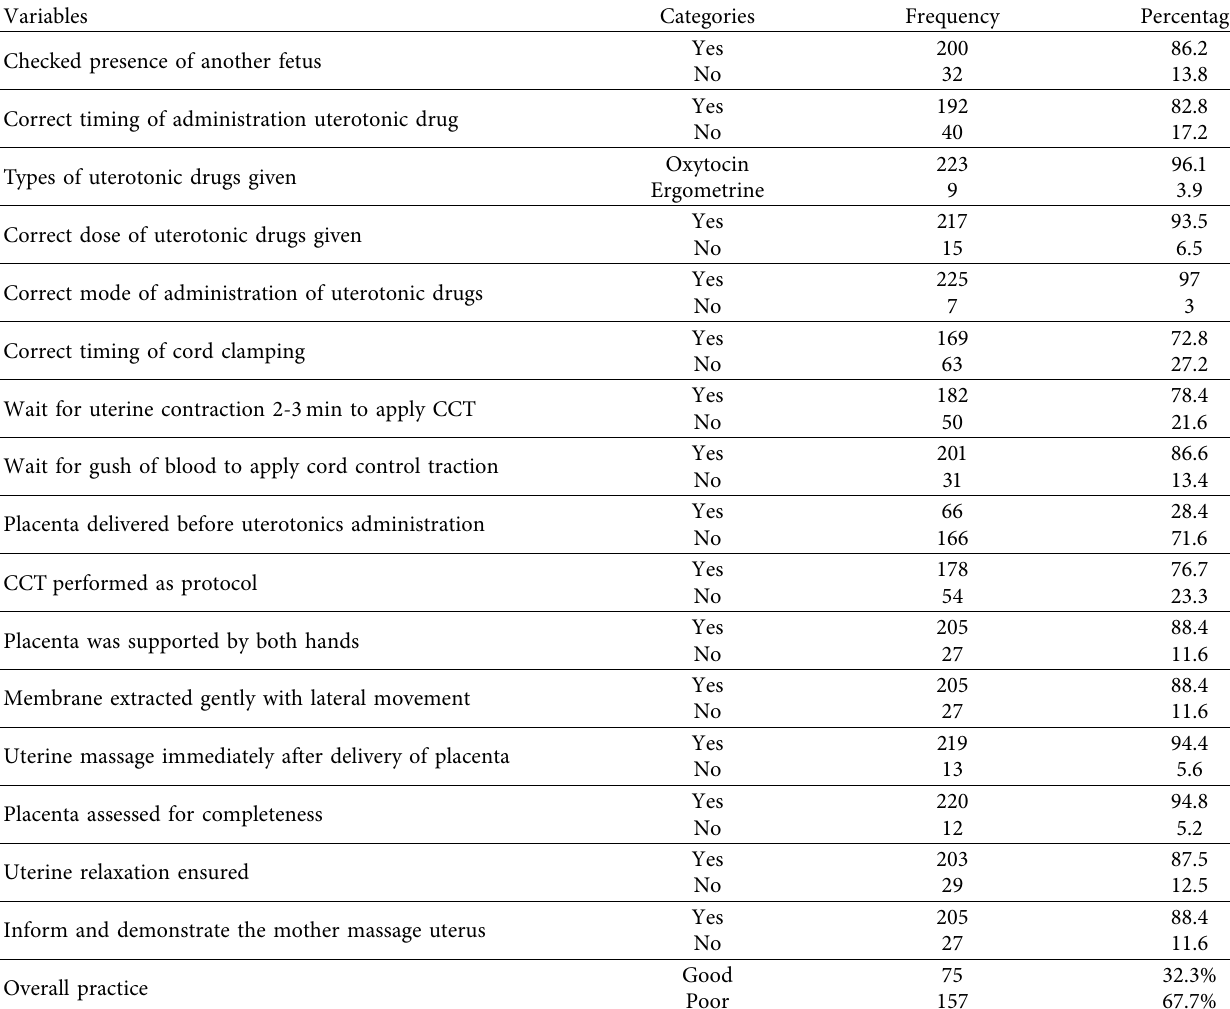
Table 4: Practice of obstetric care provider on AMTSL, 2020.